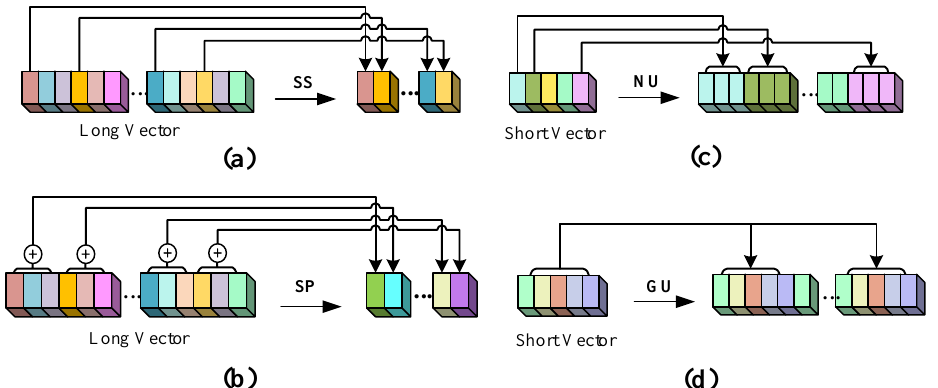
Figure 3. Feature vector size alignment. ( a ) Long vector sub-sampling (SS). ( b ) Long vector sumpooling (SP). ( c ) Short vector nearest-neighbors upsampling (NU). ( d ) Short vector global up- sampling